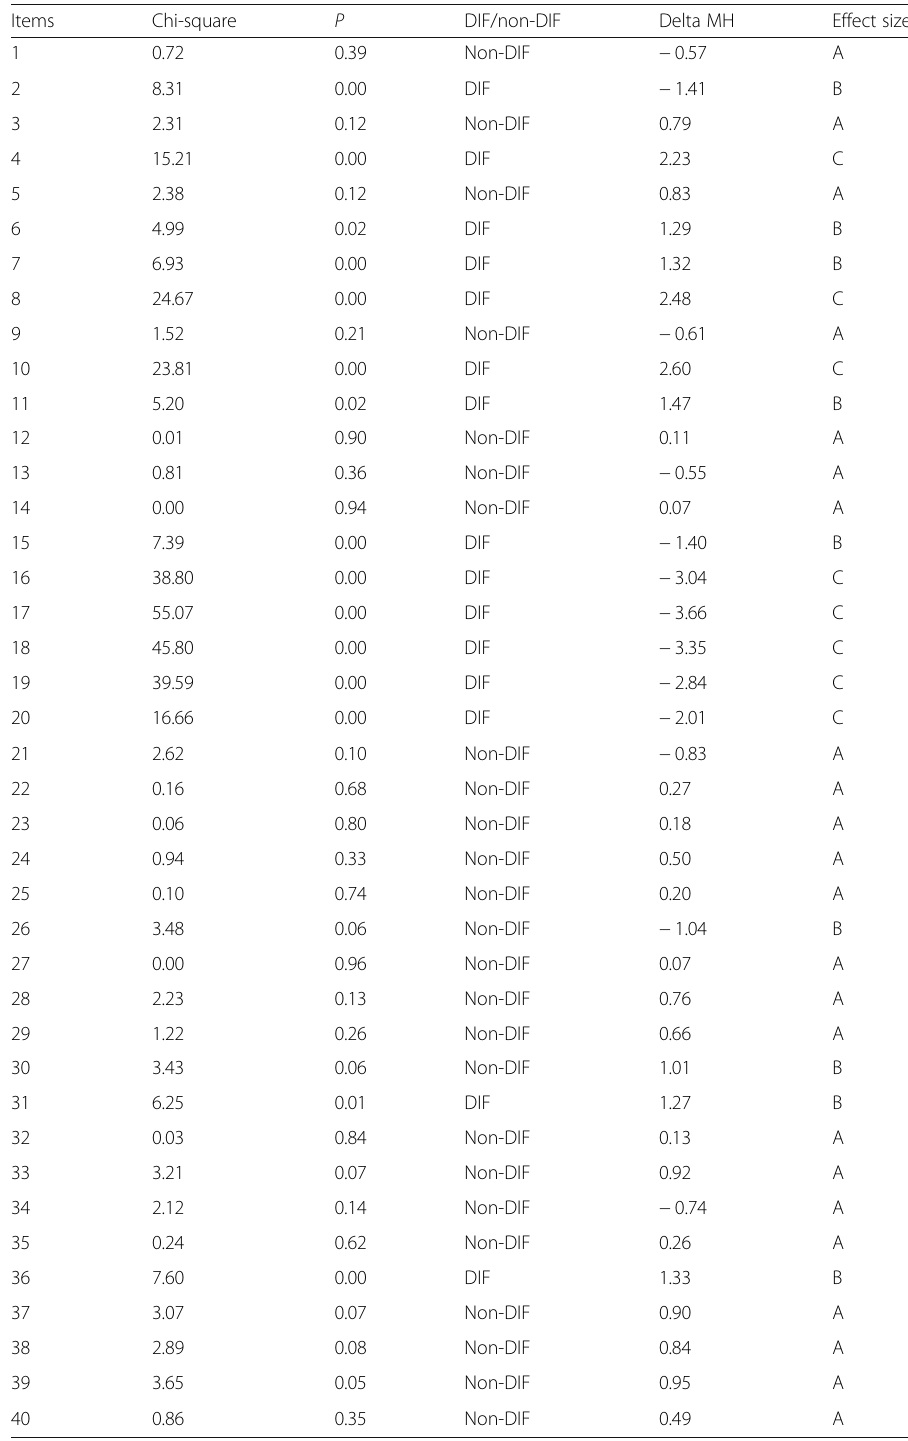
Table 8 Differential item functioning through Mantel-Haenszel ’ s method